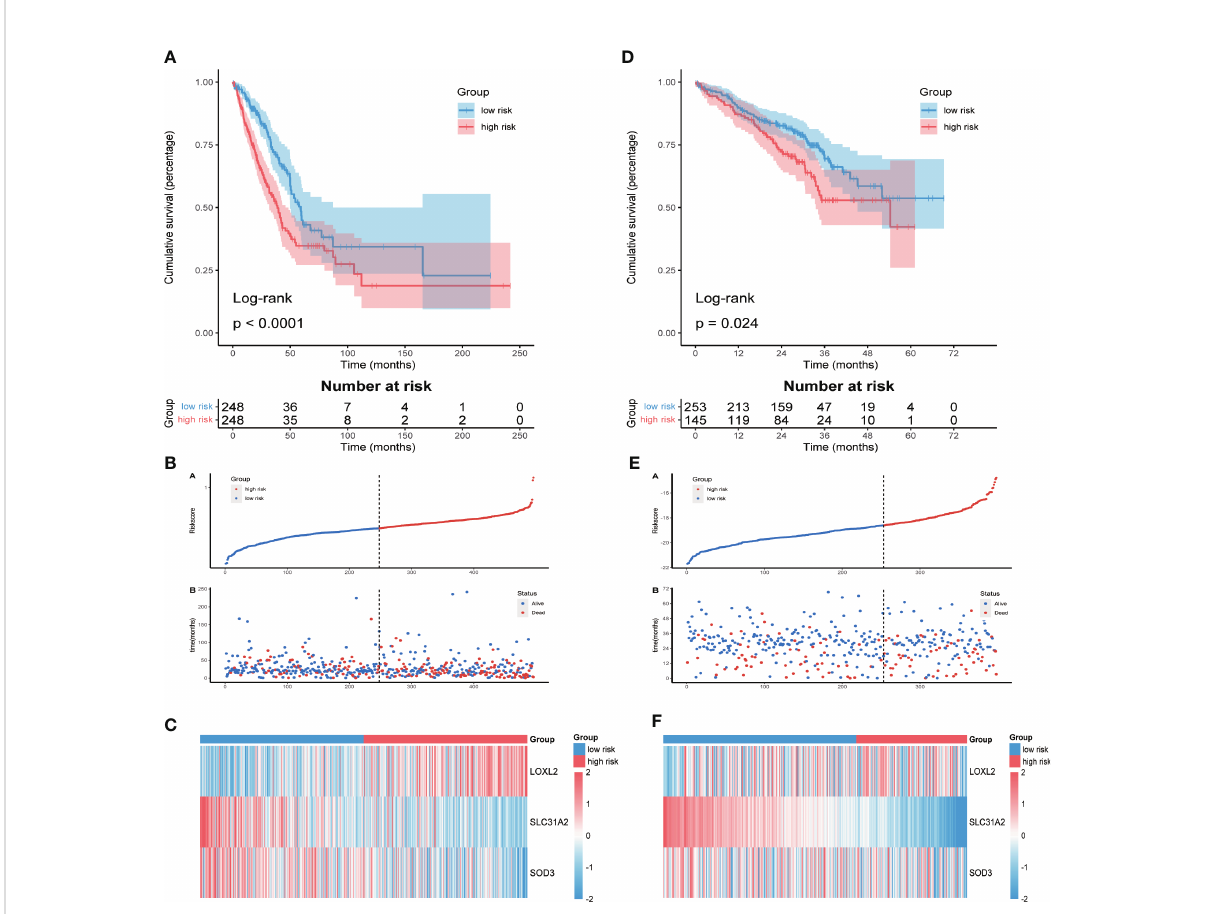
FIGURE 2 Assessment and validation of prognostic value of CMRGS. (A) Kaplan-Meier survival curves of OS in TCGA cohort. (B) Distribution of risk score and OS status in TCGA cohort. (C) Heatmap of the three CMRGs in TCGA. (D) Kaplan-Meier survival curves of OS in GSE72094. (E) Distribution of risk score and OS status in GSE72094. (F) Heatmap of the three CMRGs in